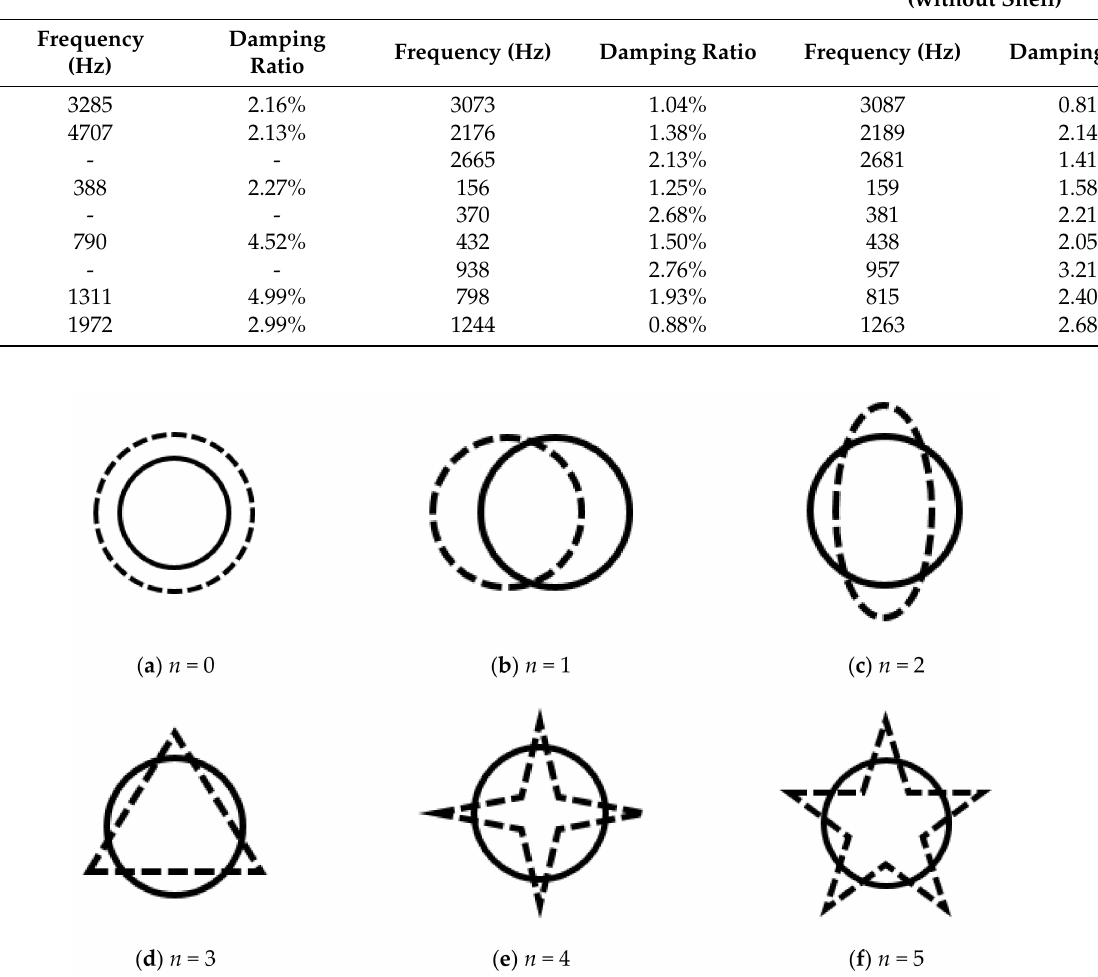
Figure 5. Schematic diagrams of modal shapes of motor stator ( m =